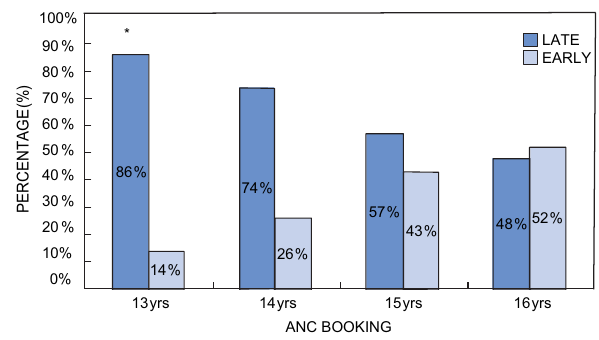
Figure 1: Age stratified by ANC booking in adolescents at a district hospital for the period 2011–2013. Early booking = < 20 weeks; late